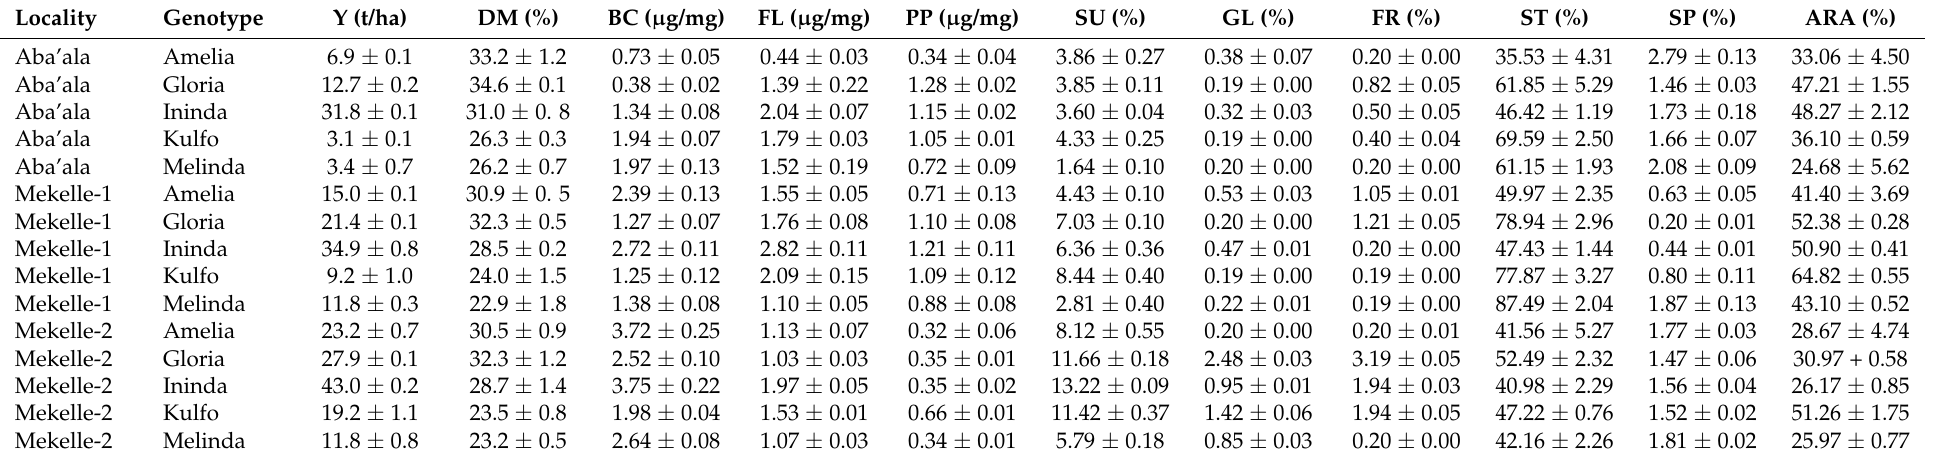
Table 3. Storage root yield and nutraceutical traits (mean ± standard error) of sweet potato genotypes at the three investigated